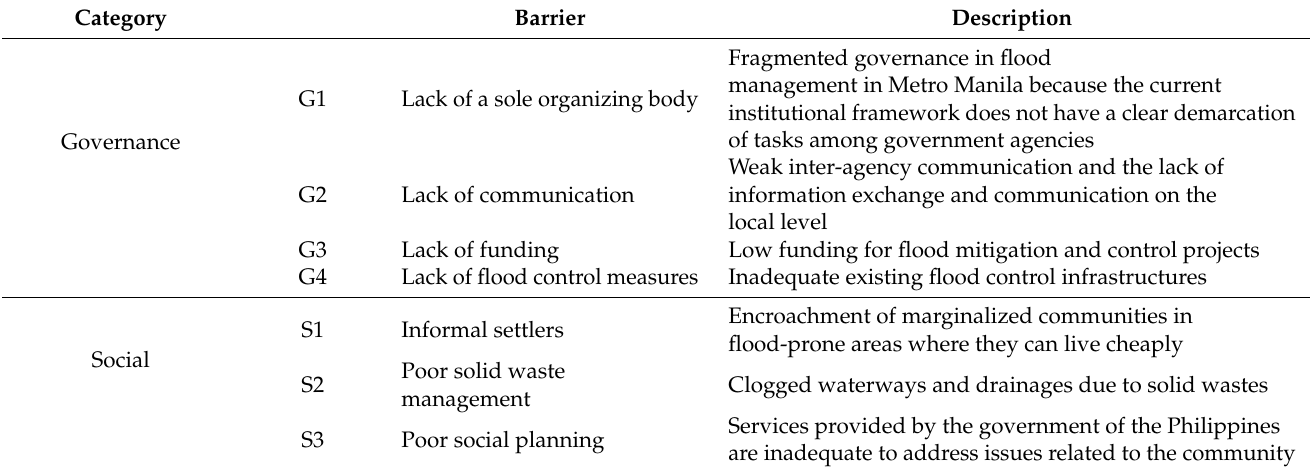
Table 1. Barriers to IFRM adaptation in Metro Manila, Philippines. (See Reference [5] for